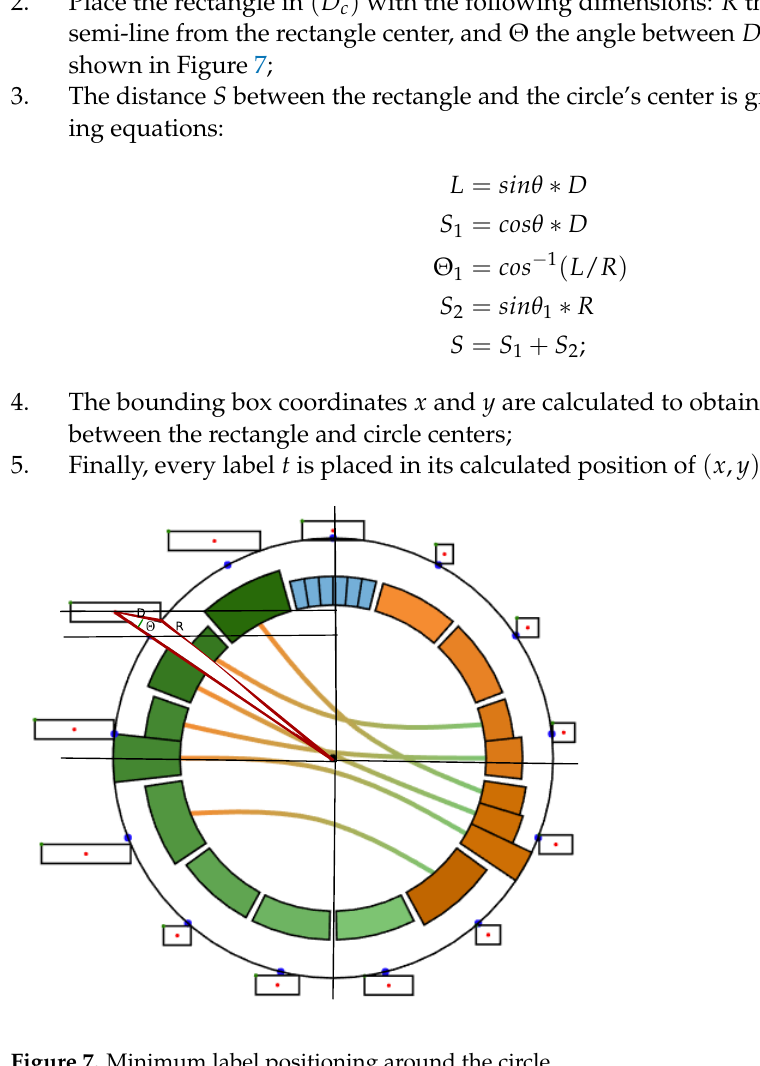
Figure 7. Minimum label positioning around the